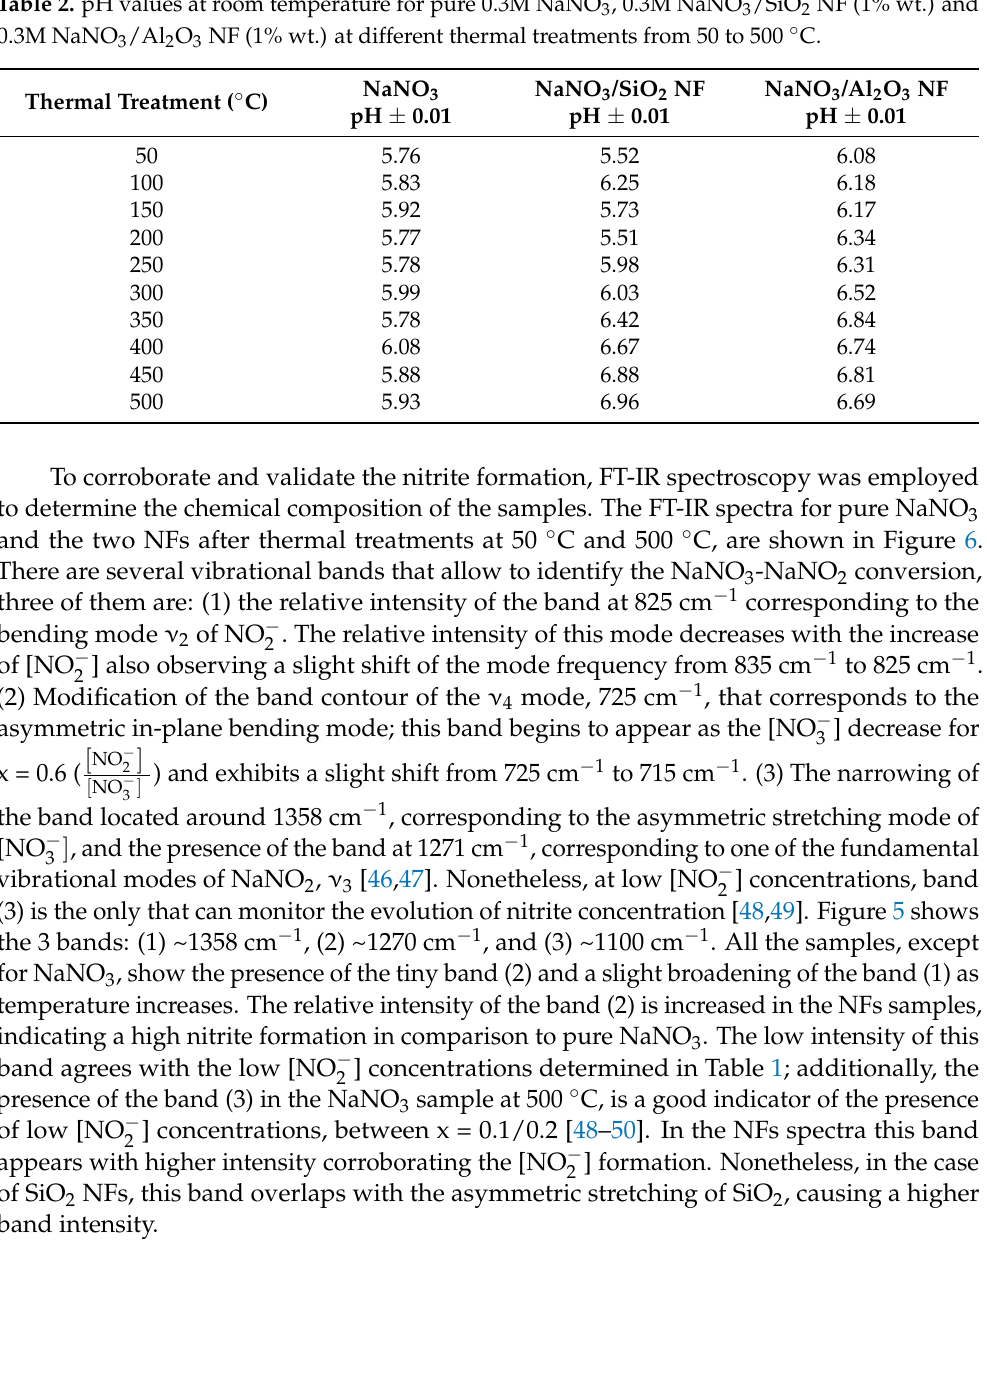
Table 2. pH values at room temperature for pure 0.3M NaNO 3 , 0.3M NaNO 3 /SiO 2 NF (1% wt.)